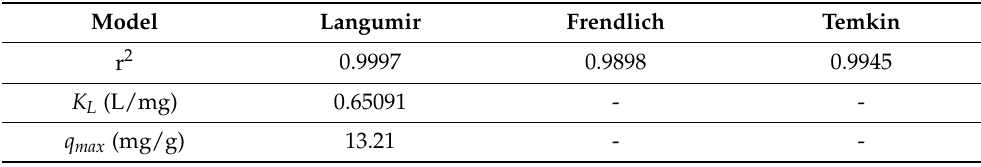
Table 2. The constants of isotherm modeling for methyl violet adsorption onto β -cyclodextrin polymer. Figure 9. Adsorption isotherm of methyl violet onto cyclodextrin polymer at room temperature, T = 30 °C.